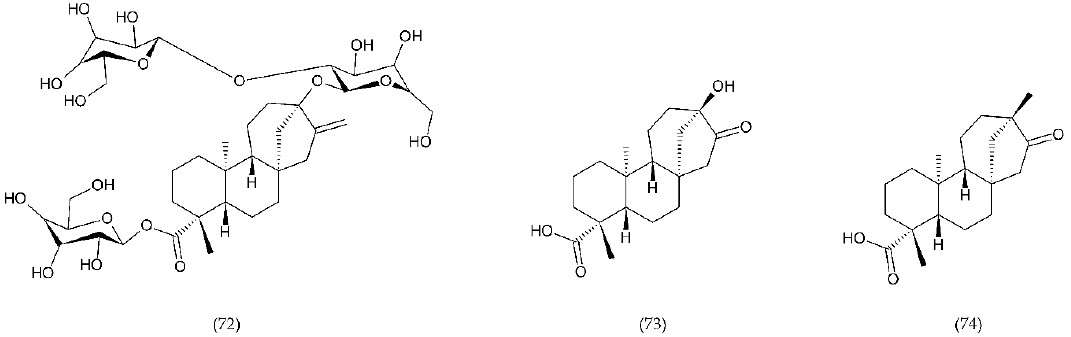
Figure 22. Chemical structure of diterpenoids: stevioside (72), steviol (73), and isosteviol (74).